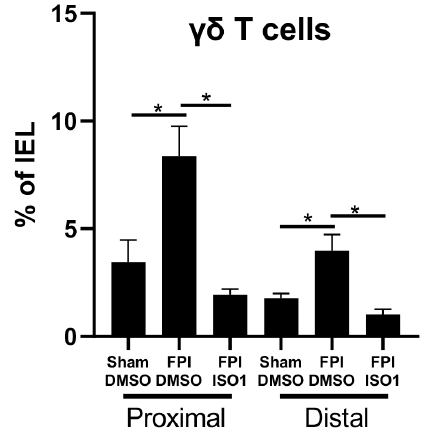
Figure 4. Effects of ISO1 on the frequency γδ T cells on the gut after FPI. We administered ISO1 using 10 mg/Kg at 30 min after FPI, and performed flow cytometry on leukocytes isolated from either proximal or distal intestine 24 h following FPI to assess what percentage of isolated leukocytes are γδ T cells. T cells were stained with anti-CD3 antibody and counter-stained with anti- γδ antibody. The percent of T cells that are γδ T cells are significantly increased in the gut after FPI. One way ANOVA * p < 0.05. N = 6 per group, error bars = SD.